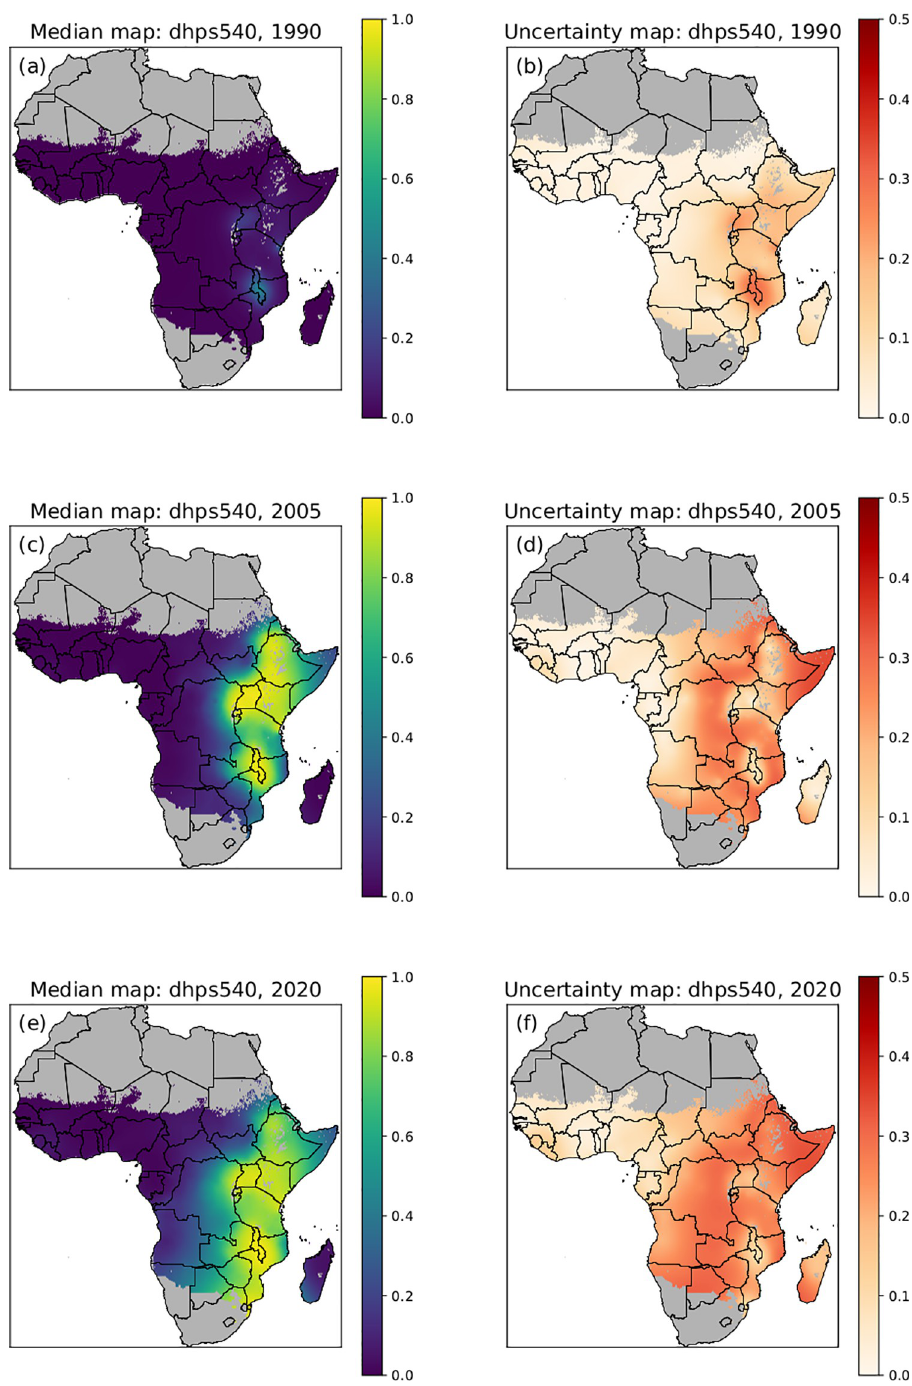
Fig 3. Posterior predictive median prevalence of pfdhps 540E. Posterior predictive median prevalence of pfdhps 540E in 1990 (a), 2005 (c) and 2020 (e). Associated standard deviations (uncertainty) for pfdhps 540E posterior predictions in 1990 (b), 2005 (d) and 2020 (f). A low standard deviation (lighter colour) indicates low uncertainty and high confidence in the model. National shapefiles were obtained from the Malaria Atlas Project (MAP; https://malariaatlas. org/) under their open access policy (https://malariaatlas.org/open-access-policy/) and no changes were made.